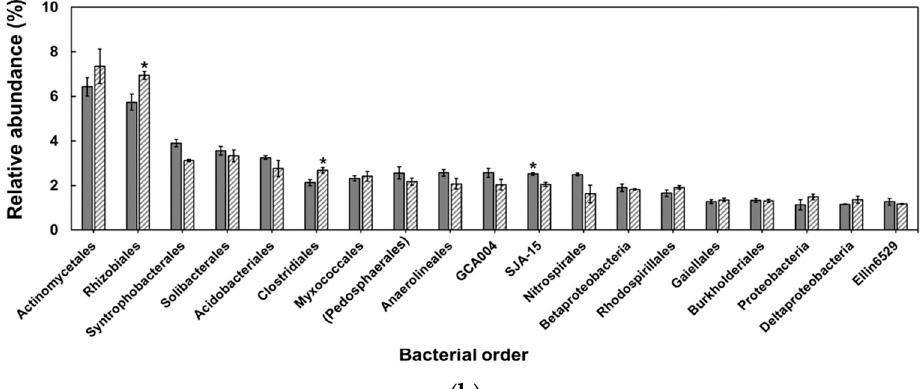
Figure 2. The relative abundances of the 20 most abundant bacterial ( a ) phyla and ( b ) orders in the studied soil samples. The phylum/order significantly different according to ANOVA is marked by asterisk (*: p < 0.05; **: p < 0.01).